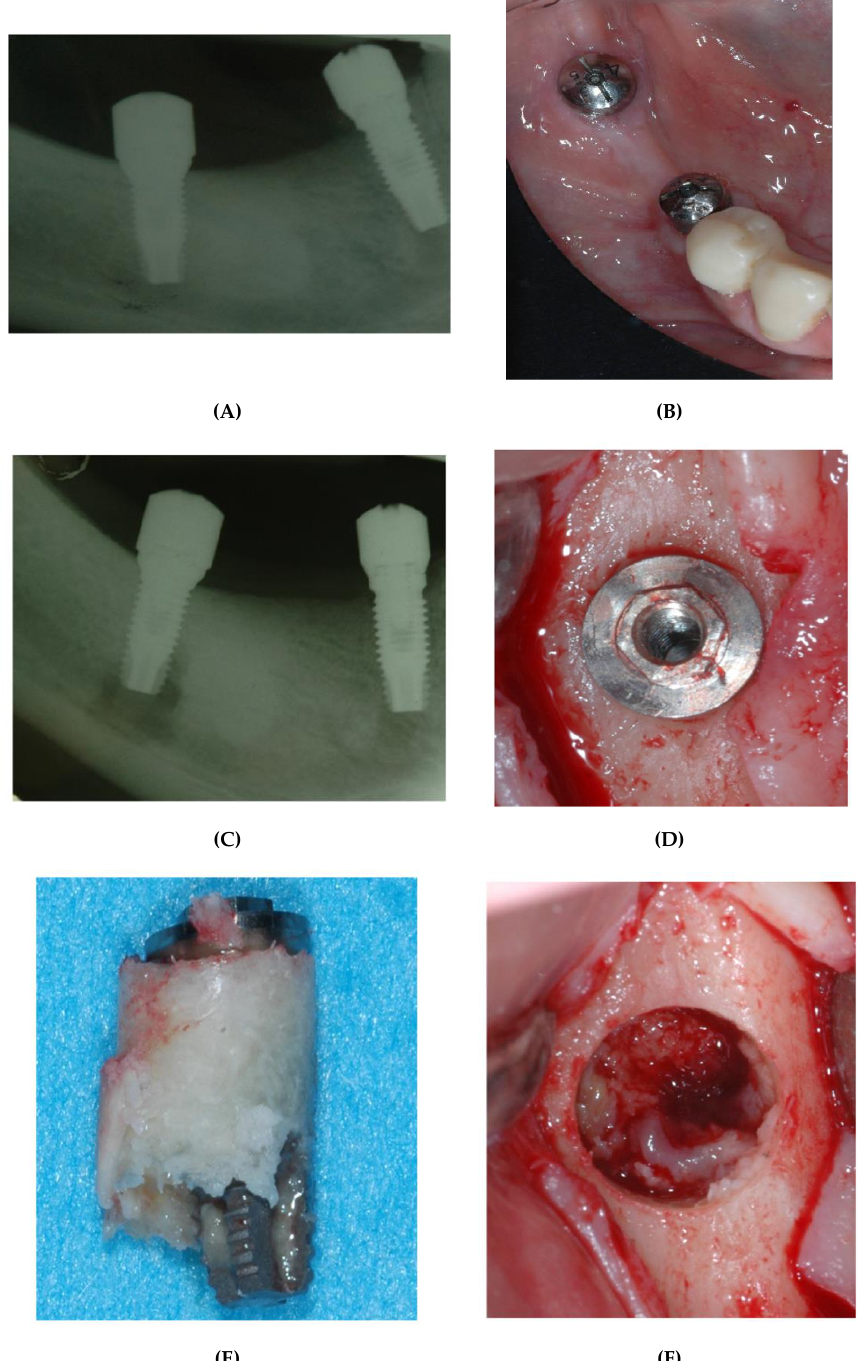
Figure 3. ( A ) Postoperative intraoral radiograph showing the position of the implants at #45 and #47. ( B ) Intraoral radiograph taken one month after the intervention. An area of radiolucency is visible at the apex of the implant at #47. ( C ) Clinical image 6 weeks after the implantation: there are no